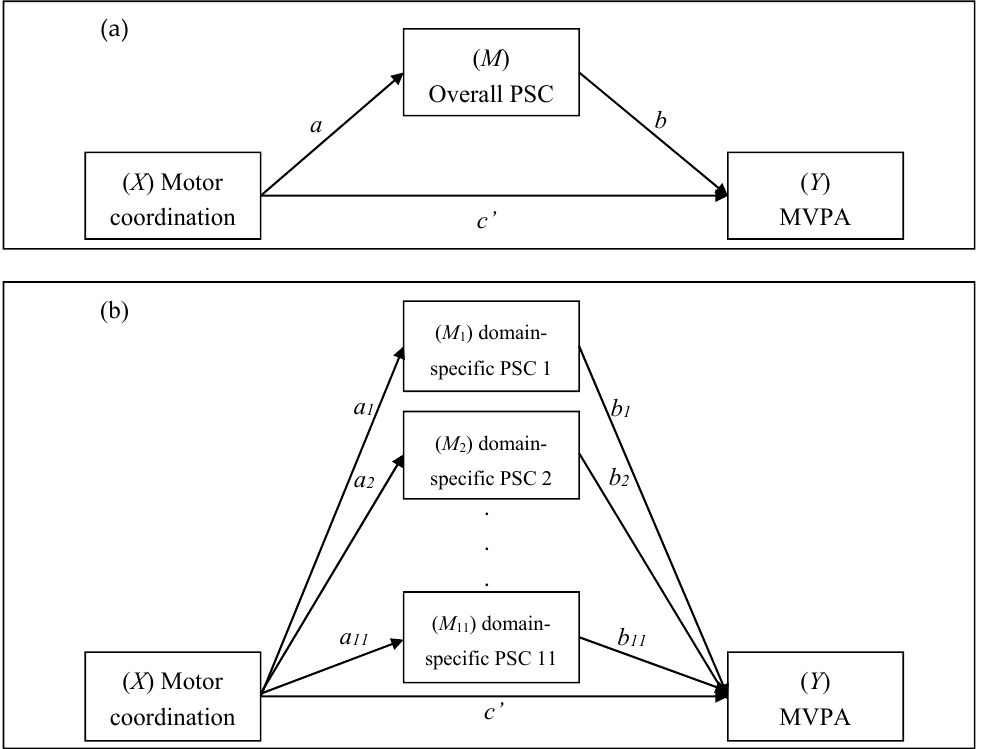
Figure 1. Conceptual diagrams of ( a ) the simple mediation model and ( b ) the parallel multiple mediator model. Note: a indicates the unstandardized coe ffi cient from X to M , b indicates the unstandardized coe ffi cient from M to Y , and c ’ indicates the unstandardized coe ffi cient from X to Y . MVPA: moderate-to-vigorous physical activity; PSC: physical self-concept